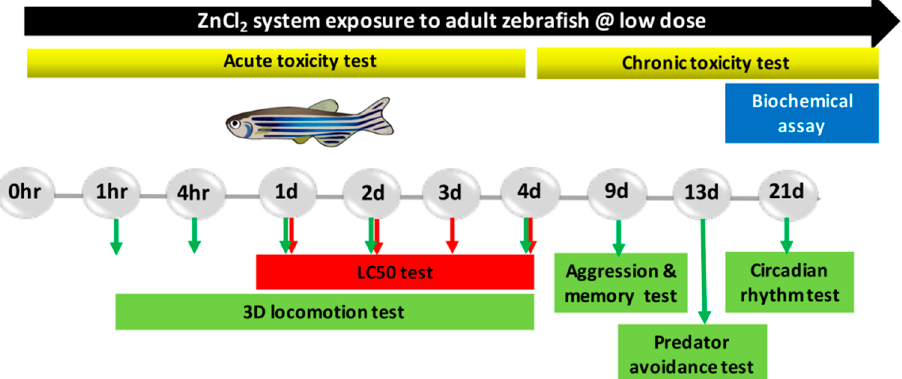
Figure 1. Experimental design scheme of adult zebrafish exposed to ZnCl 2